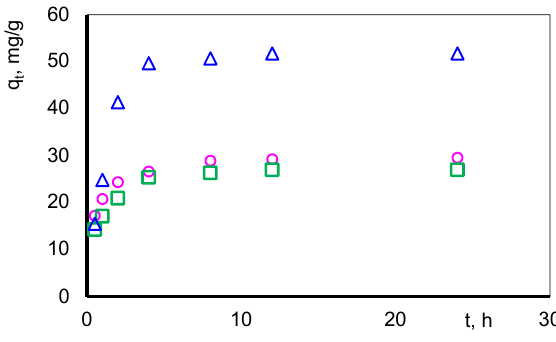
(cid:3) ) and Pb(II) ( ∆ )